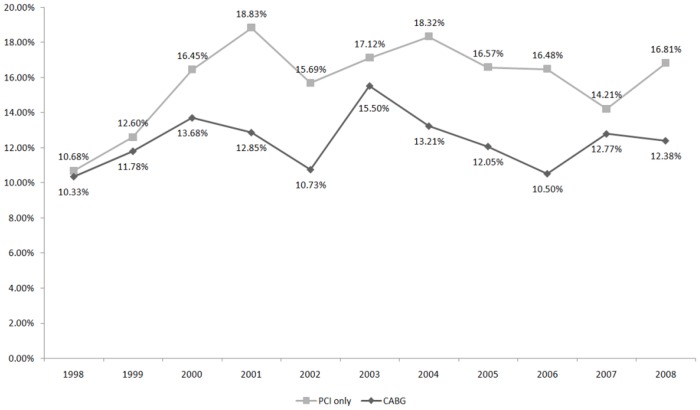
Trends of in-hospital all-cause mortality in patients treated with IABP combined with coronary revascularization, 1998–2008.Abbreviations: IABP, intra-aortic balloon pumping; PCI, percutaneous coronary intervention; CABG, coronary artery bypass grafting surgery. * The mortality rate was calculated by dividing [the number of patients who underwent PCI or CABG, were treated with IABP, and died in a particular year] by [the total number of patients who underwent PCI or CABG and were treated with IABP in that particular year]. * p = trends of in-hospital all-cause mortality over time: PCI group, p = 0.1767; CABG group, p = 0.7501.